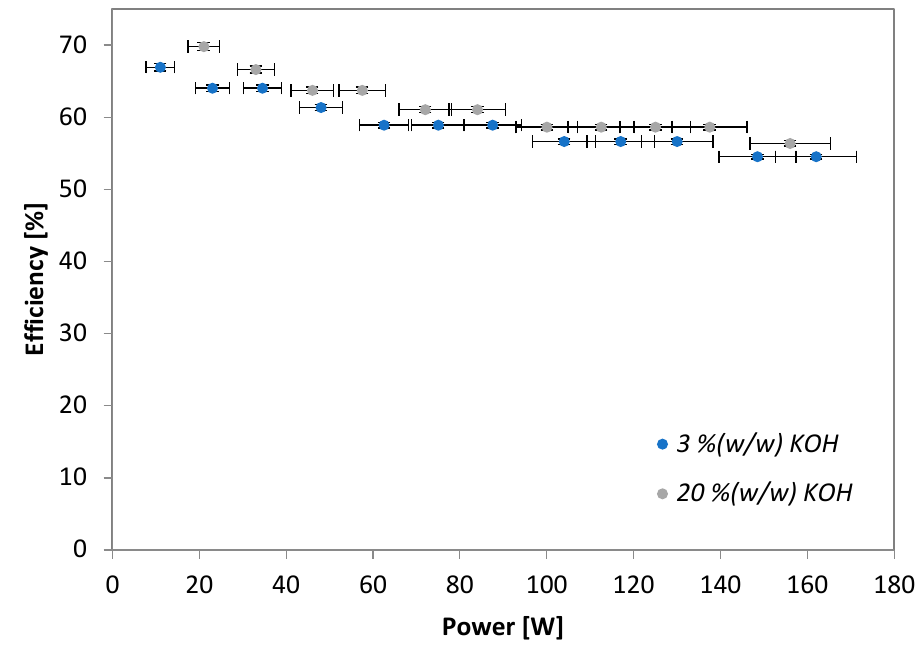
Figure 8. Efficiency evolution with injected power, for 3 and 20% ( w/w ) of KOH. Efficiencies are below η U ∼ 69.8 ± 0.6 % and are higher for lower power input, as